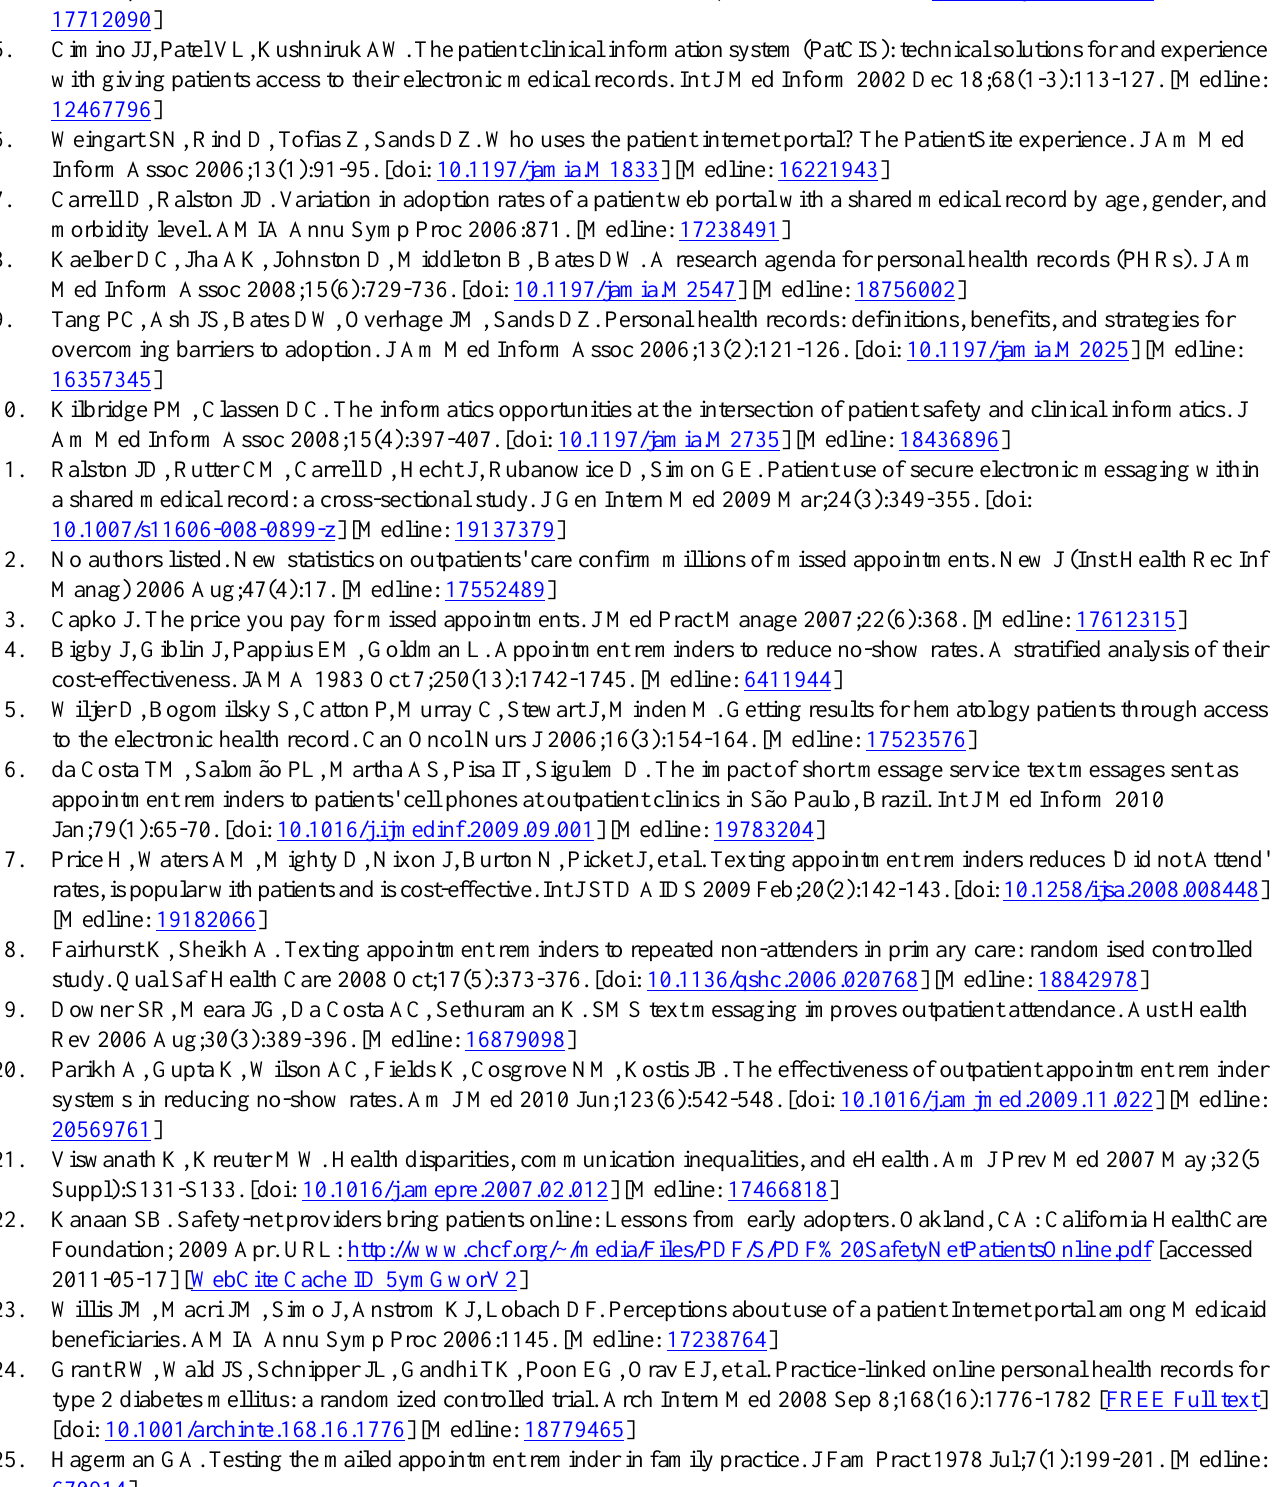
Abbreviations CI: confidence interval DCPC: Duke Children's Primary